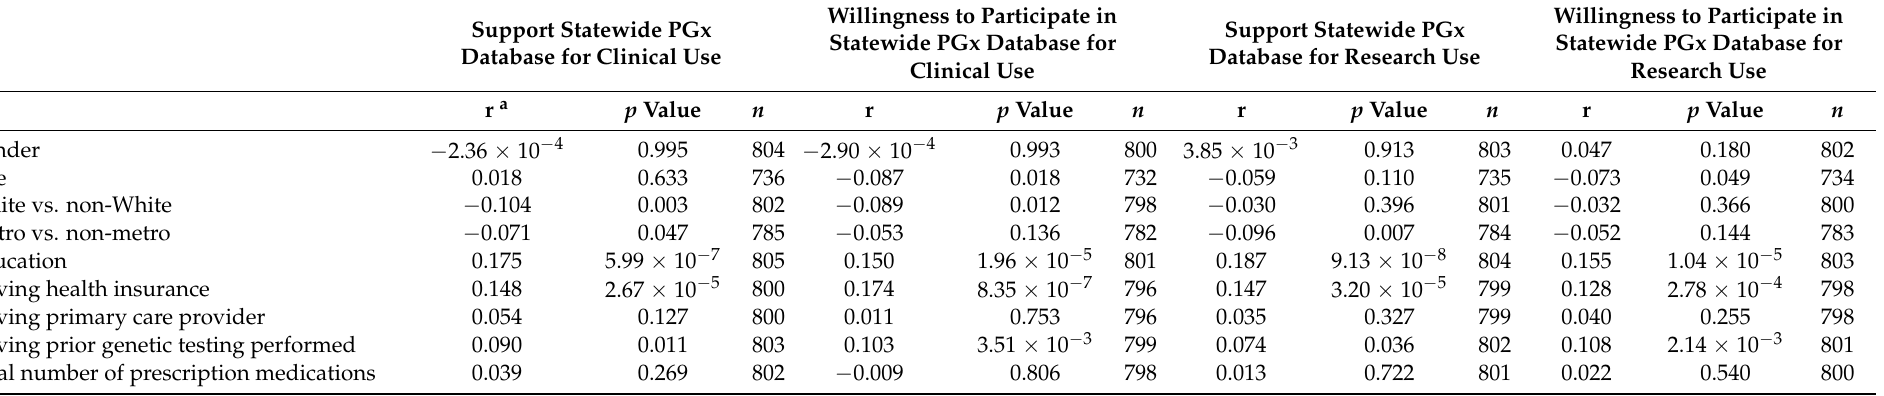
Table 2. Pairwise Spearman correlations of the acceptability of a statewide pharmacogenomic database and sociodemographic and health-related